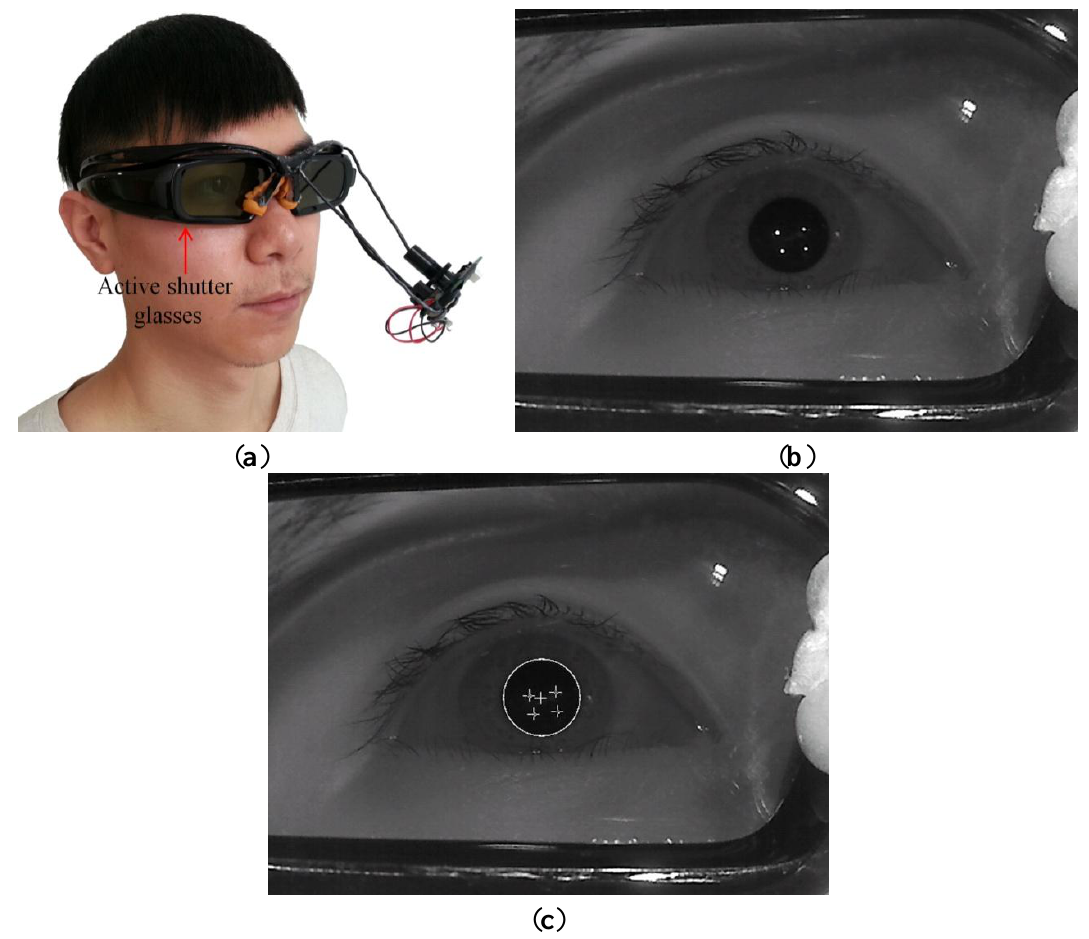
Figure 11. Examples of applying our device and method to the active shutter glasses for 3D stereoscopic display: ( a ) the case of using our device with active shutter glasses for 3D stereoscopic display; ( b ) the captured eye image; ( c ) the resulting image from successfully detecting the pupil center with four SR